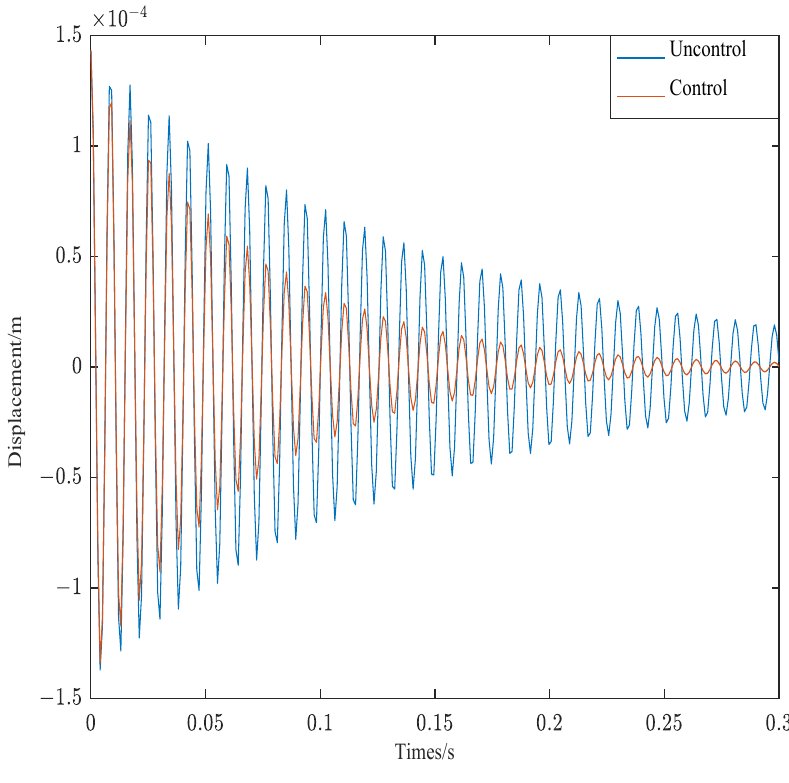
Figure 11. Response of structure 2. Table 4. Influence of different weighting parameters on structural damping ratio. Damping Ratio